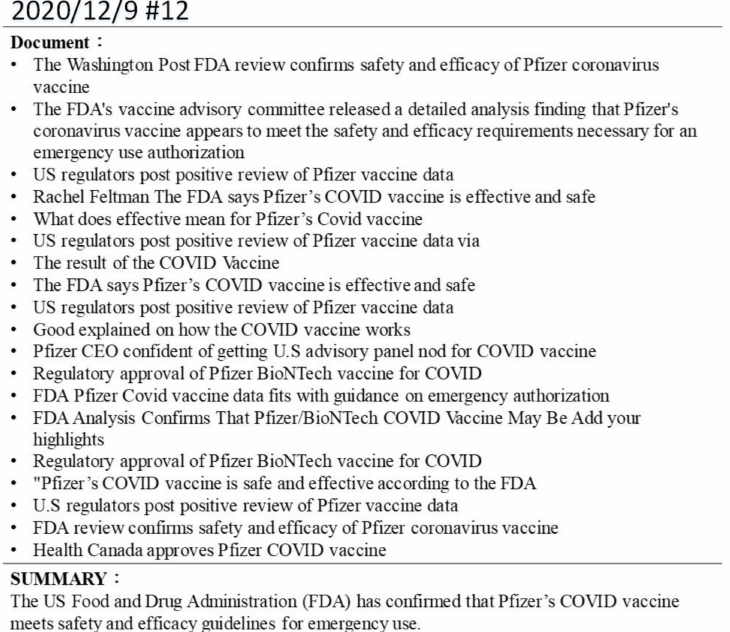
Figure A11. A sample resulting summary of formulated event topics (9 December